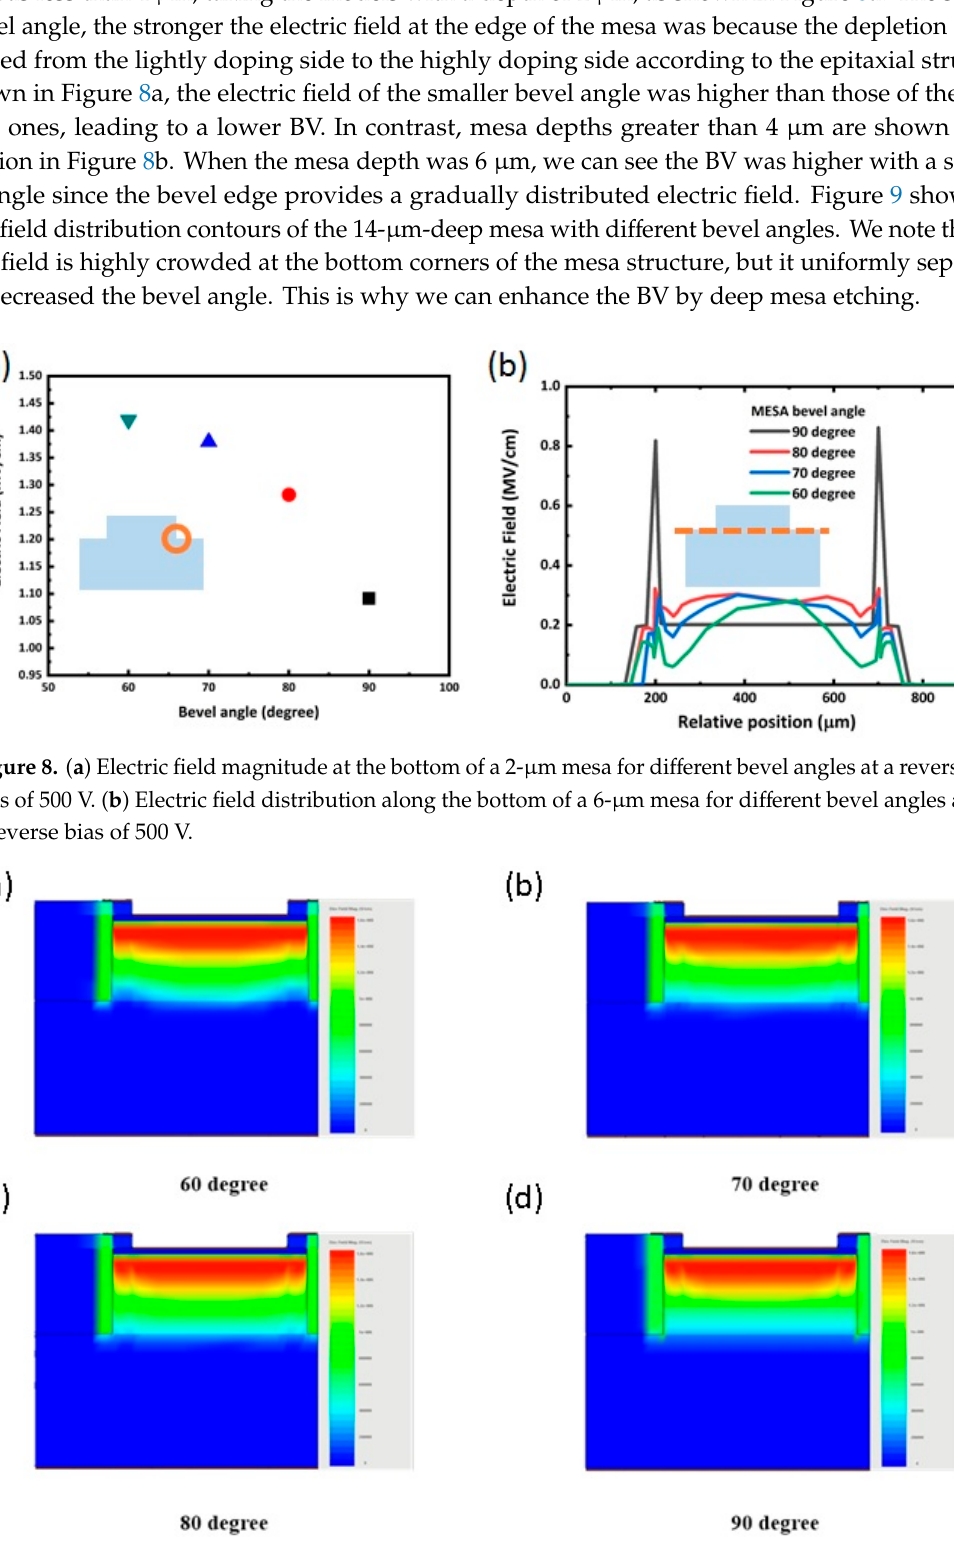
Figure 7. The electric field profile along the mesa midline for different devices at a reverse bias of 500 V.